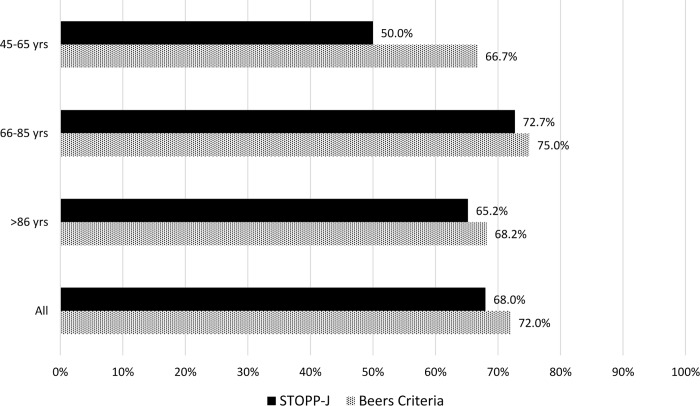
Proportion of PIM use by age.